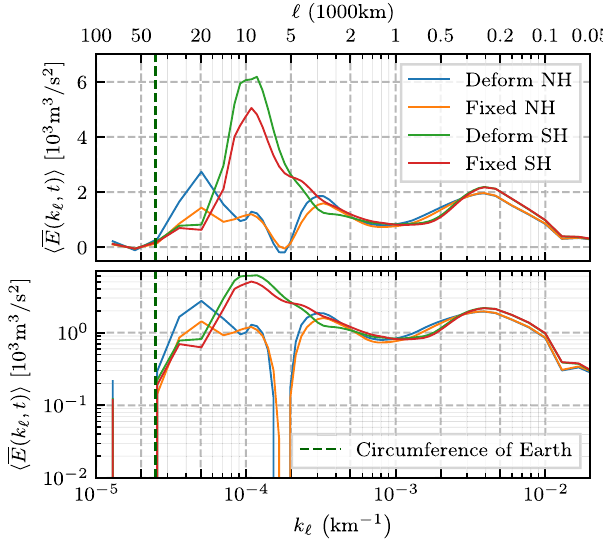
Fig. 6 | Land treatments. Filtering spectra, analogous to Fig. 2, using both deforming and fi xed kernels on the AVISO dataset for a single day (02 Jan 2015).